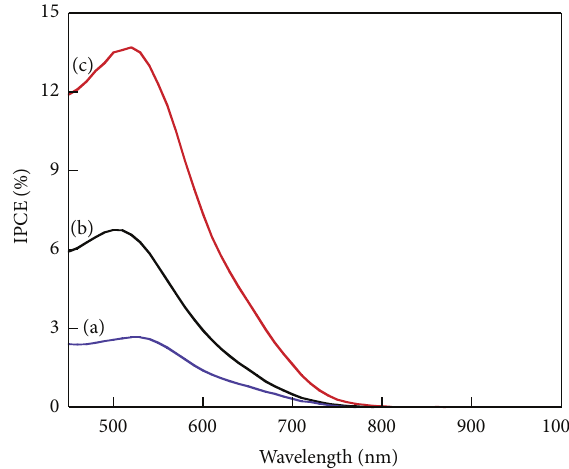
Figure4:IPCEof(a)N719-sensitizedTiO 2 photoelectrodeandafter addition of (b) 1 mM and (c) 0.1mM of